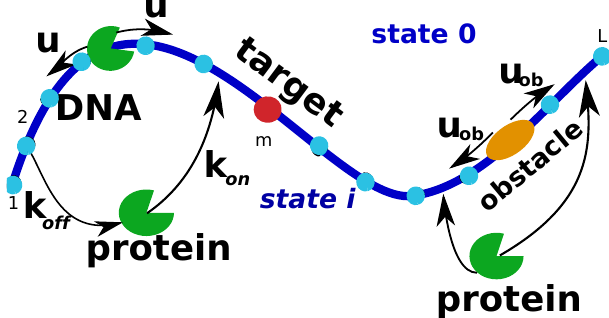
Figure 9. A schematic view of the protein target search in the presence of a moving obstacle on DNA. The crowding particle cannot dissociate from DNA, while the protein molecule can dissociate into the solution, labeled as state 0, and return back to the DNA